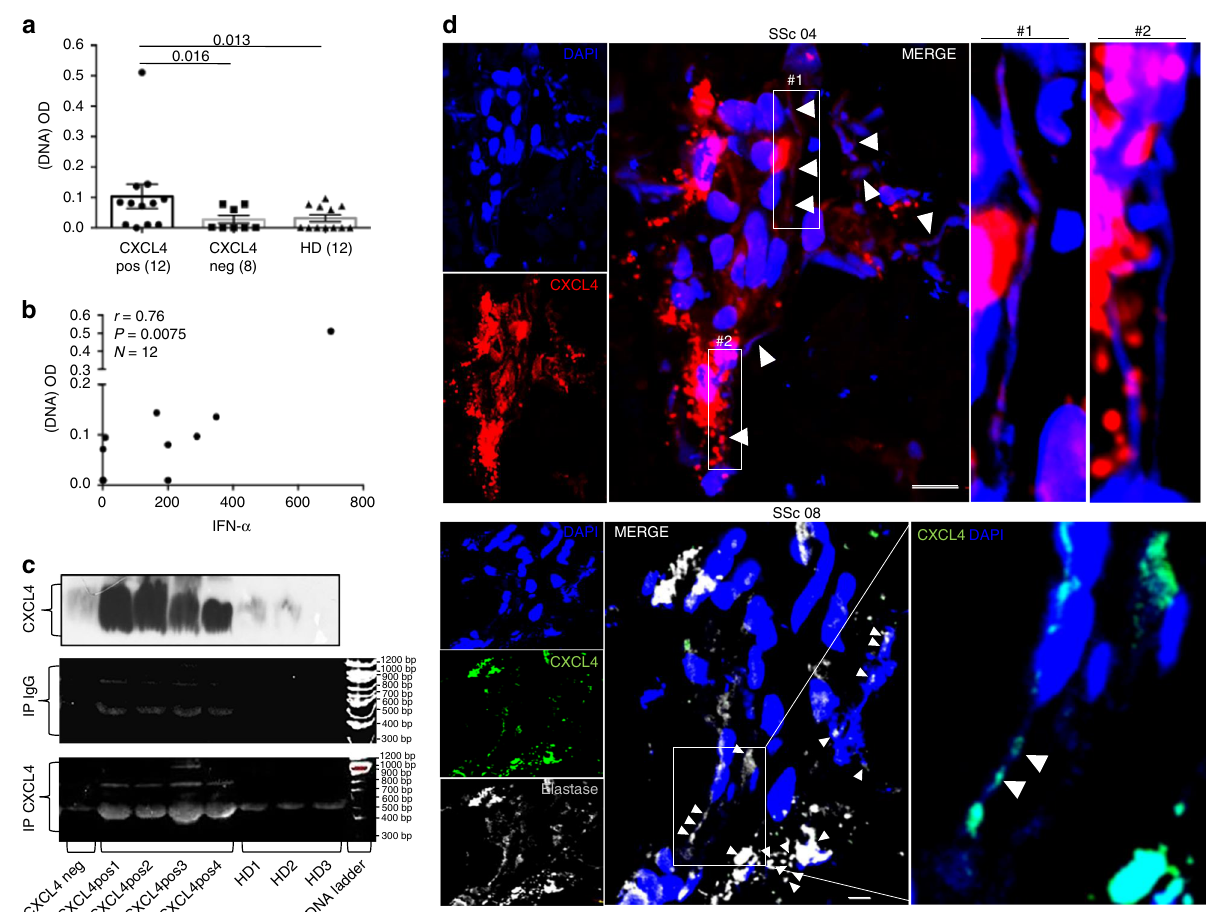
Fig. 8 CXCL4 – DNA complex detection in vivo. a SSc plasma that was either positive (SSc pos, N = 12) or negative (SSc neg, N = 8) for CXCL4 content and HD plasma (that were all negative for CXCL4 content, N = 12) were plated on 96-well plates coated with a mouse anti-CXCL4 antibody. After washing, levels of CXCL4 – DNA complexes were measured by using an anti-dsDNA antibody (see Methods, 1:300 dilution). Results are expressed as optical density (OD). Horizontal bars are the mean, vertical bars are s.e.m., P -values by Mann – Whitney test. b CXCL4 – DNA immune complexes of CXCL4-positive patients (measured as in panel a ) were plotted against IFN- α plasma levels to assess correlation between the presence of circulating CXCL4 – DNA complexes and IFN- α in SSc patients ( N = 12). Spearman ’ s correlation coef fi cient “ r ” , signi fi cance “ P ” , and sample size “ N ” , were indicated. c CXCL4 (upper panel) was immune-precipitated using an anti-CXCL4 antibody from plasma of SSc patients that were negative (SSc neg, N = 1) or positive (SSc pos, N = 4) for CXCL4 content, and from HD plasma ( N = 3). The immune-precipitated material was run on a gel (8% acrylamide) and DNA was stained by ethidium bromide. In the middle panel, ethidium bromide staining of the same SSc and HD plasma immune-precipitated for IgG – immune complexes (IP IgG, see Methods); in the lower panel, ethidium bromide staining of plasma immune-precipitated for CXCL4 (IP CXCL4). Results are representative of one experiment of two performed, with different SSc and HD plasma. d LSM images relative to the presence of extracellular traps in skin biopsies from two different SSc patients out of four that show DNA fi laments (blue, DAPI), CXCL4 in red (upper panels, patients SSc 04), or in green (lower panels, patient SSc 08), elastase in gray (lower panel) (magni fi cation ×63; bar, 5 µ m). CXCL4 – DNA complexes are indicated by white arrowheads; high-power images of some of the indicated complexes are provided as insets for both patients. Results from two biopsies of eight